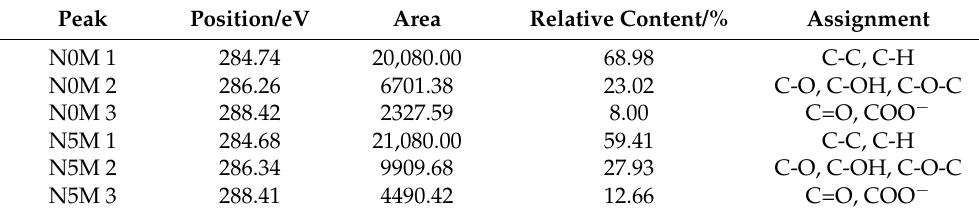
Figure 8. XPS C1S spectra for lignite and nitric acid-modified lignite. Table 4. XPS C1S synthesized data of lignite and nitric acid-modified lignite.